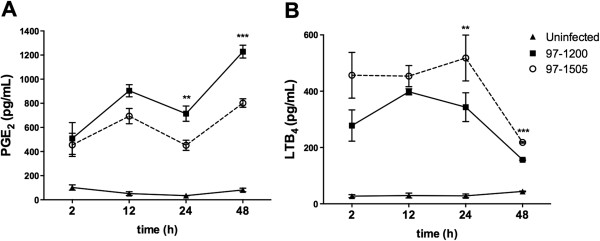
LTB4 and PGE2 production by alveolar macrophages is differentially induced by PLC-expressing Mycobacterium tuberculosis. Cells were infected with Mtb isolates 97-1200 or 97-1505 for 2, 12, 24, and 48 hours and the eicosanoid production was assessed in the supernatants by ELISA. ***P < 0.0001; **P < 0.001 (one-way ANOVA). Data are representative of three (A) and two (B) independent experiments (error bars, s.e.m.).